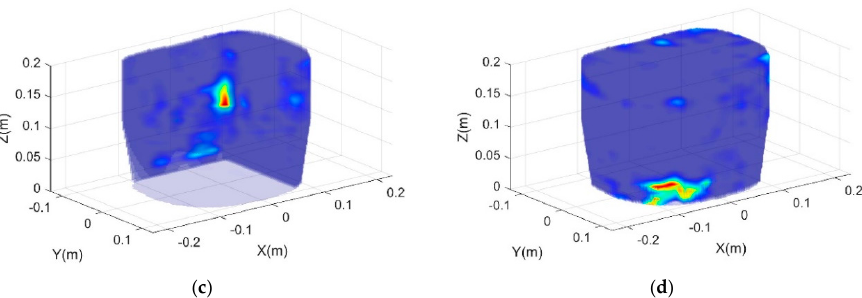
Figure 8. ( a ) Water located inside a plastic bag and its size is compared to the phantom lungs. ( b ) Two different positioning that water was located inside the lungs. ( c ) Constructed image for case 1, where water is located at rear side of the left lung, and ( d ) case 2, where water is located at the lower side of the right lung.